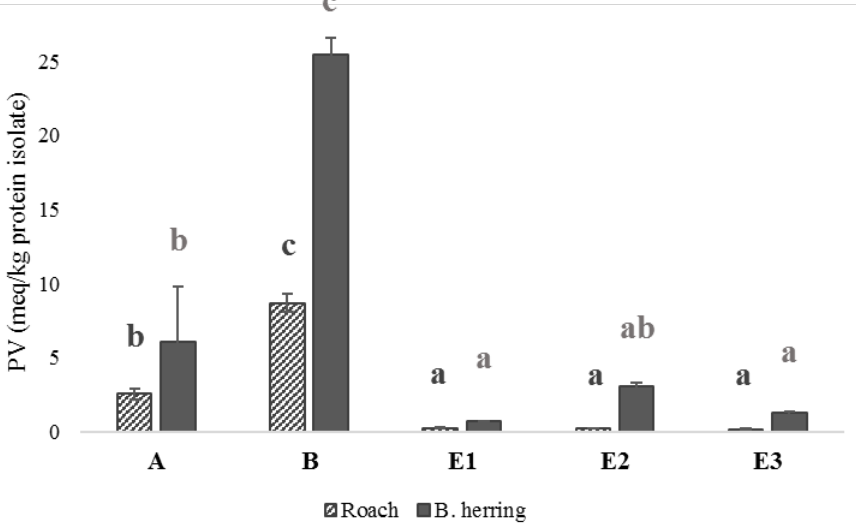
Figure 3. Peroxide values (meq/kg protein isolate) in protein isolates produced using acidic or alkaline pH shift and hydrolysates produced using Protamex, Neutrase, or Corolase. Different letters within the same raw material (roach or B. herring) indicate a statistically significant difference ( p < 0.05).